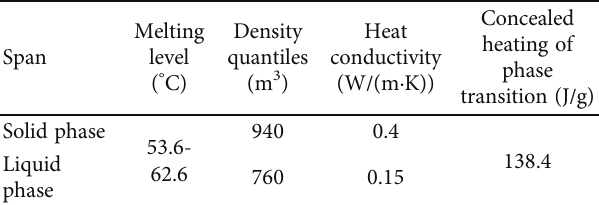
Figure 1: Para ffi n DSC curve. Table 1: The thermophysical properties of para ffi n